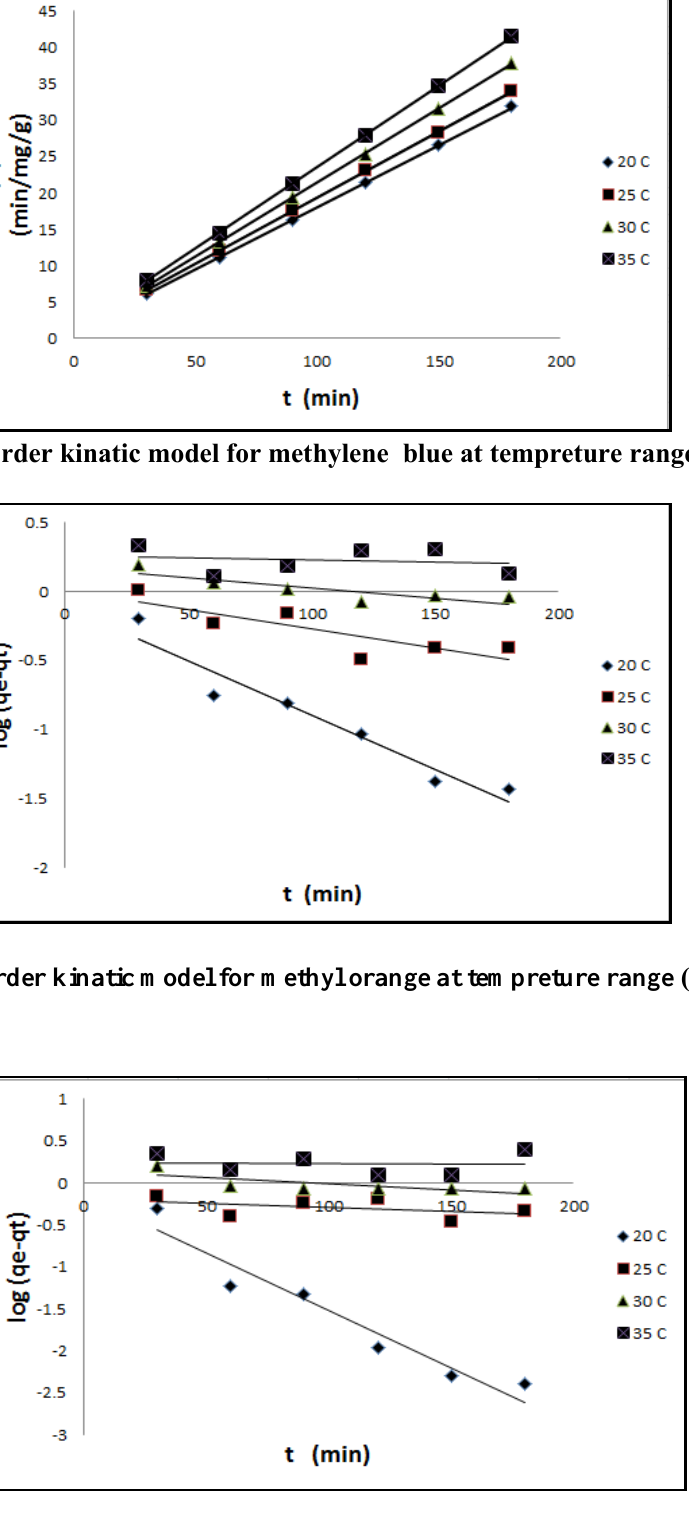
Fig. 12. first order kinatic model for methylene blue at tempreture range (20−35)